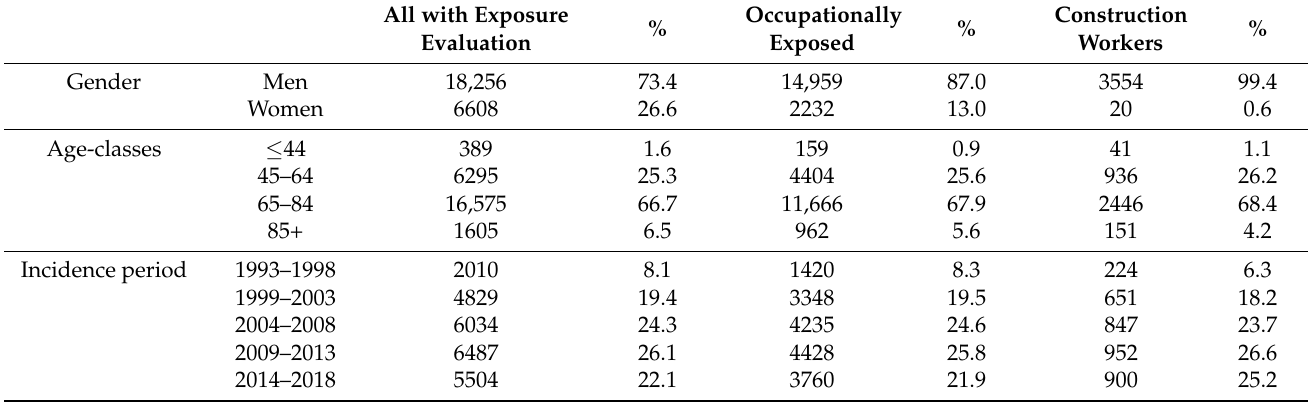
Table 1. Distribution of MM cases (overall, occupational exposed and in the construction sector) by gender, age classes, incidence period, anatomical site, diagnostic certainty, histopathological characteristics, and modality of exposure. Italy.